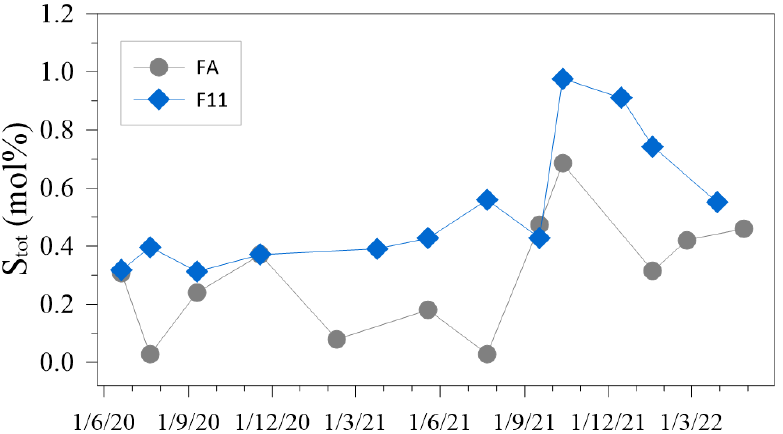
Figure 4. Time trends of total sulfur contents in the vapor of fumaroles FA and F11. In coincidence with CO 2 anomalies, the carbon isotope composition of CO 2 (i.e., δ 13 C-CO 2 ) increased to values as high as δ 13 C-CO 2 = 0 ‰ in March and September 2021. The carbon isotope composition remained at values close to 0 ‰ vs. VPDB from September onward, with CO 2 contents still above 10 mol%, although decreasing over time (Figure 5a).